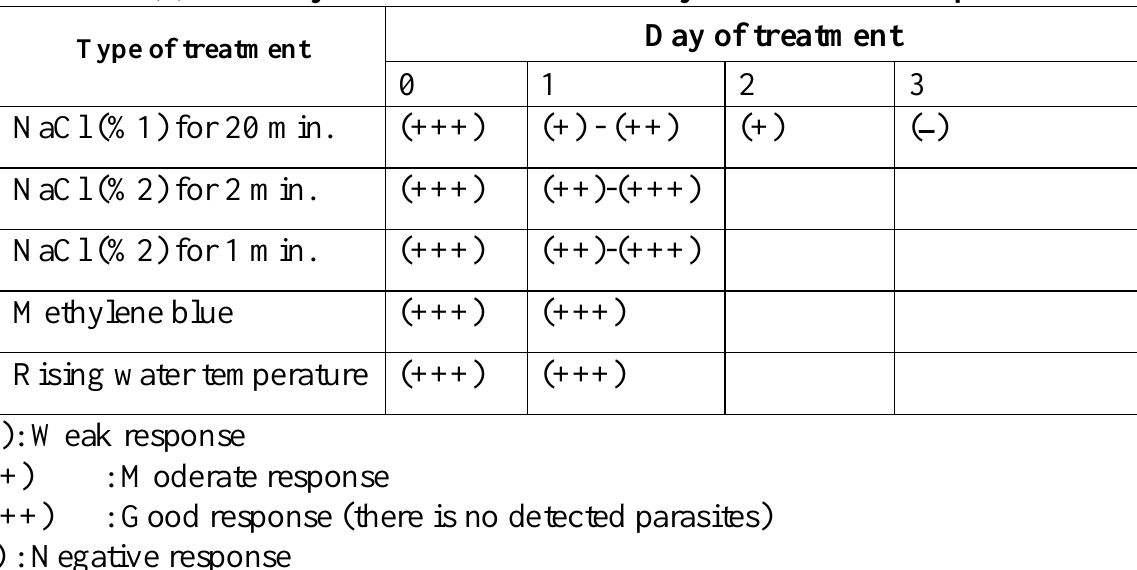
Table (1): Efficacy of treatment on Tetrahymena in infected pet fish Day of treatment Type of treatment 0 1 2 3 NaCl (%1) for 20 min. (+++)